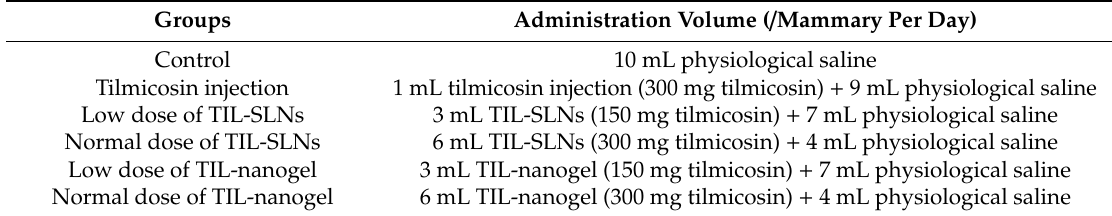
Table 1. The dosage regimen of S. aureus mastitis treatment